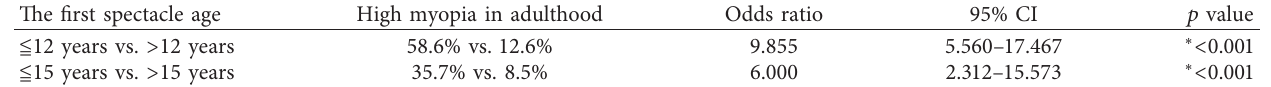
Table 2: The first spectacle age and the high myopia prevalence in adulthood.